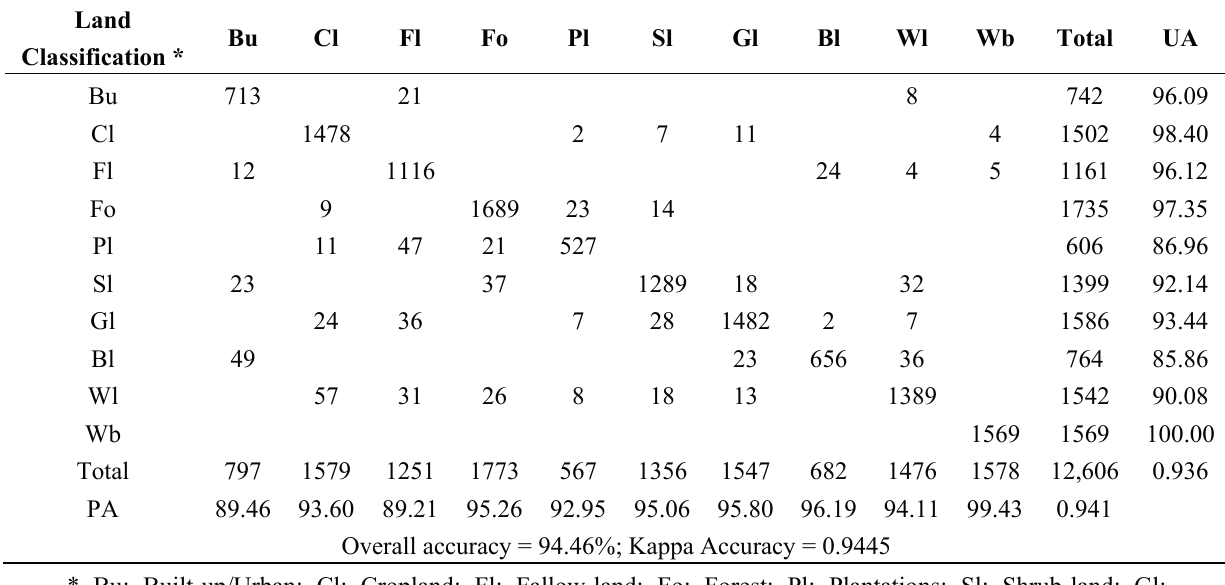
Table 5. Accuracy of evaluation of LULC types for the year